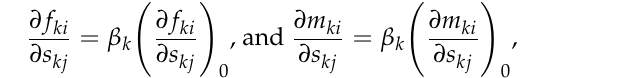
Figure 13. Spectrum of rope tension ( L C = L D = 60 m P T 0 . 1 , 0   == ). Figure 14a demonstrates the dynamic tension spectrum with L C = 140 m and L D = 60 m. In Figure 11a, with the rope lengths L C = L D = 60 m, the maximum dynamic tension T Ad = 84.56 tons. In Figure 14a, with the rope lengths L C = 140 m, L D = 60 m, the maximum dynamic tension T Cd = 171.8 tons. It is because the surge and heave displacements of the pontoon 3 and platform at the resonance in Figure 14b are significantly larger than those in Figure 11b. Moreover, the pitch angle of the platform in Figure 14c is significantly larger than that in Figure 11c.